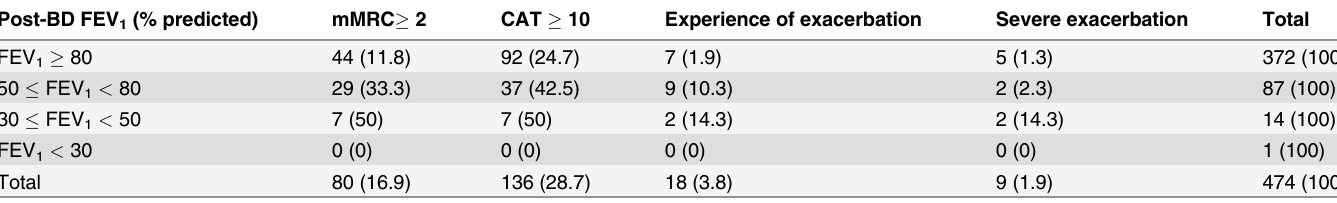
Table 3. Distribution of air fl ow limitation, level of symptoms, and exacerbation of COPD among COPD patients. Post-BD FEV 1 (%